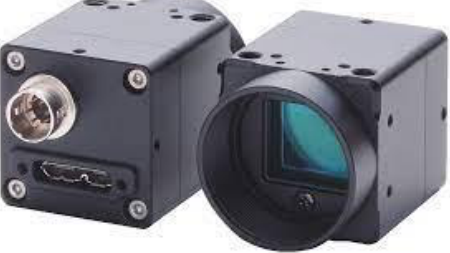
Figure 31. Vision system. Table 3. Camera technical specifications.